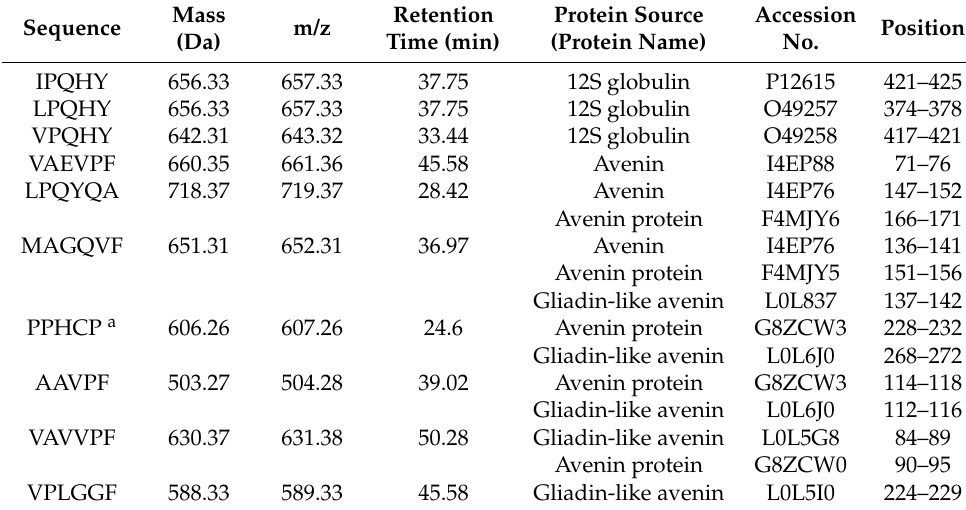
Table 2. Identification information of the oat-protein-derived peptides.